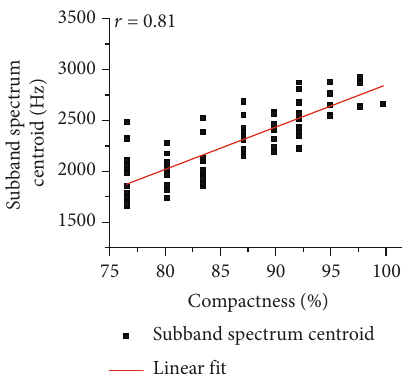
Figure 11: Correlation graphs of soil samples with di ff erent compaction degrees under the action of 55(L) N hammering force and the centroid of sound subband spectrum.